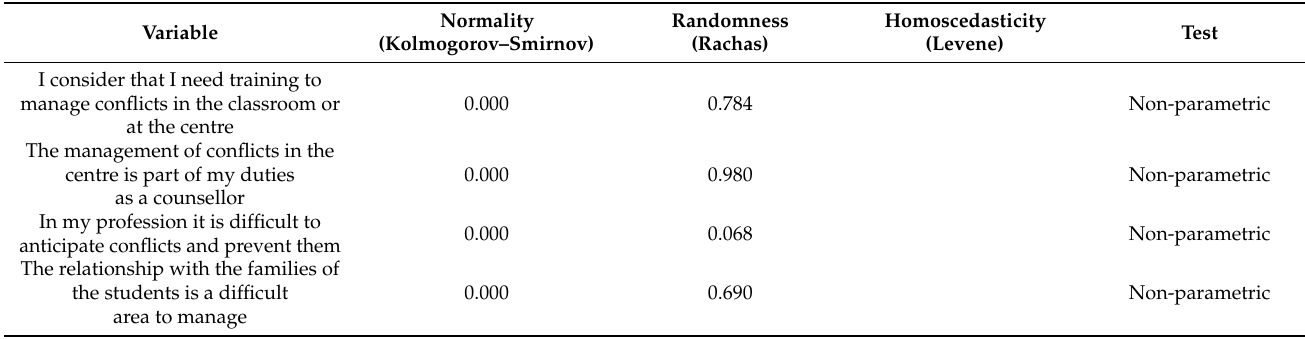
Table A1. Tests applied to the qualitative